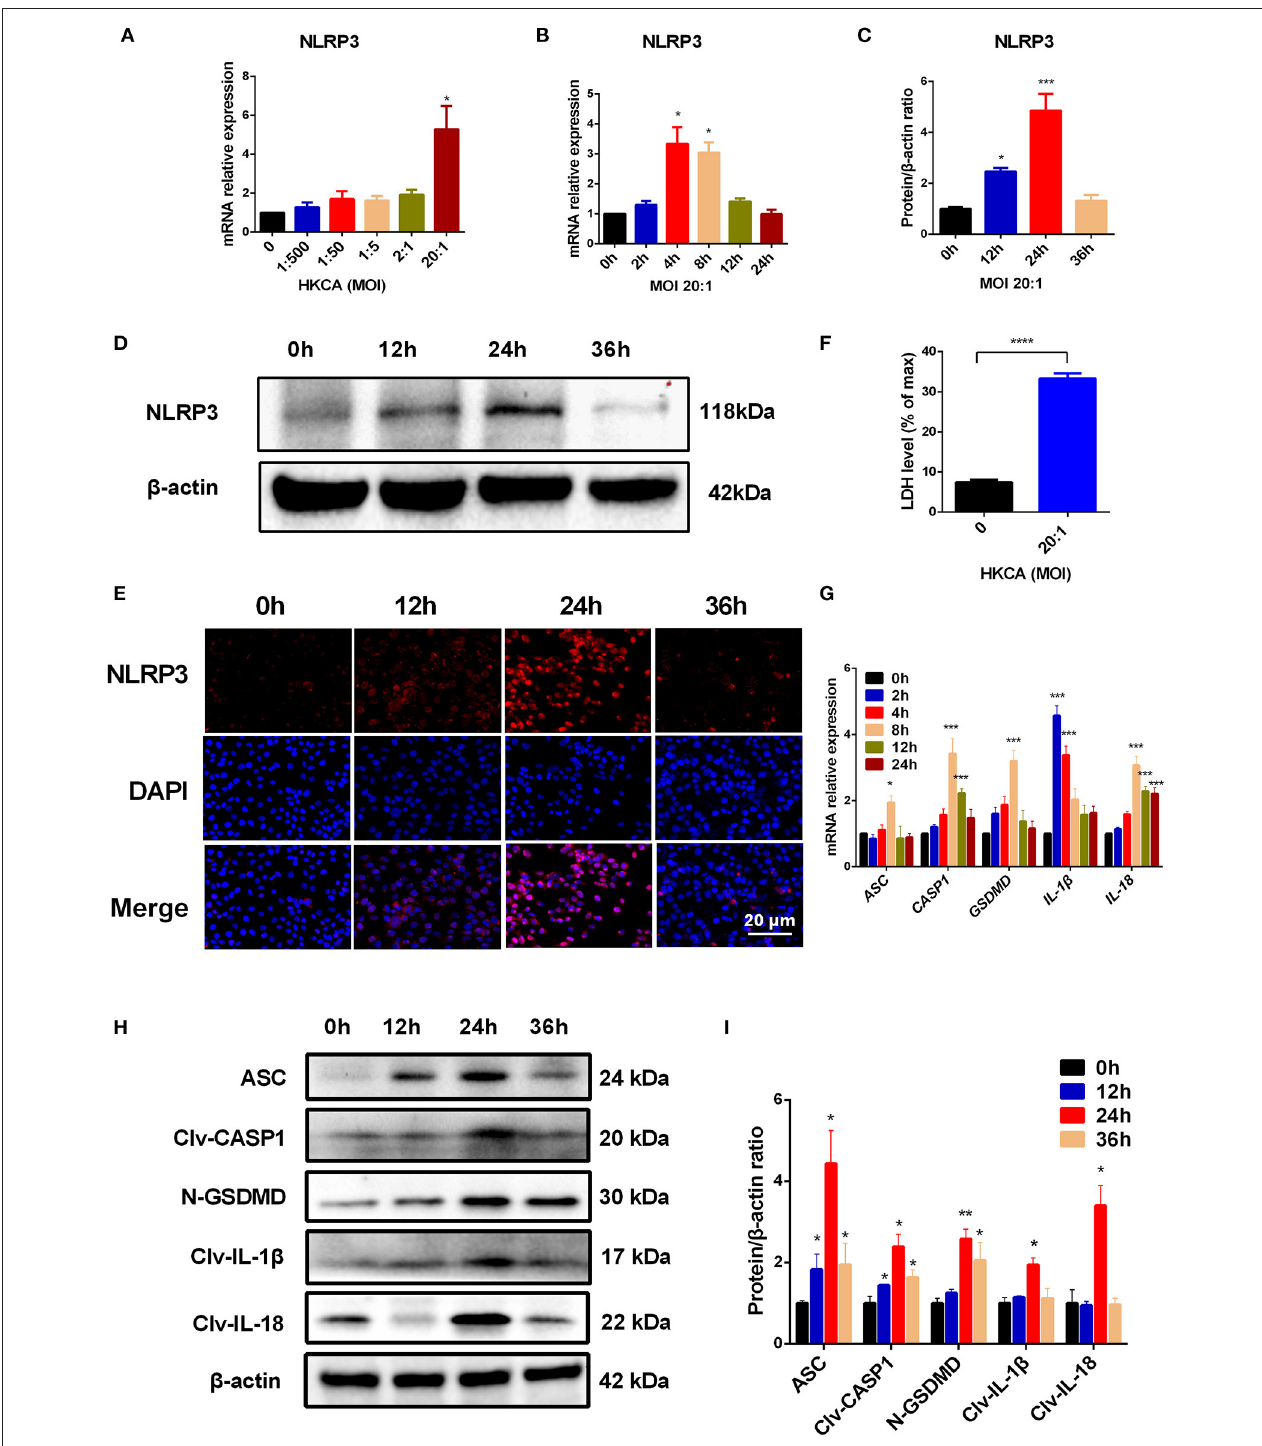
FIGURE 5 | Heat-killed C. albicans (HKCA) activates NLRP3 inflammasome and induces pyroptosis in human corneal epithelial cells (HCECs). (A) The mRNA expression of NLRP3 in HCECs challenged with HKCA at an MOI of 1:500, 1:50, 1:5, 2:1, or 20:1 respectively for 4 hours was evaluated by RT-qPCR ( n = 5). (B–D) The mRNA and protein expression of NLRP3 in HCECs exposed to HKCA (MOI = 20) for 0 (control), 2, 4, 8, 12, or 24h ( n = 3). (E) NLRP3 fluorescence intensity was evaluated using immunofluorescent staining for different times (12–36h). ( n = 3; Scale bar = 20 µ m; magnification 400 × ). (F) Lactate dehydrogenase (LDH) of HCECs treated with HKCA (MOI = 20) for 24h ( n = 6). (G) The mRNA levels of ASC, CASP1, IL-1 β , IL-18 and GSDMD in HCECs exposed to HKCA (MOI = 20) for different times ( n = 3). (H,I) The protein expression of pyroptosis-related proteins (ASC, cleaved CASP1, N-GSDMD, cleaved IL-1 β and cleaved IL-18) was examined by western blot ( n = 3). CASP1: caspase-1; Clv-CASP1: cleaved CASP1; Clv-IL-1 β : cleaved IL-1 β ; Clv-IL-18: cleaved IL-18; N-GSDMD: cleaved p30 form of GSDMD. All values are presented as mean ± SEM. * p < 0.05; ** p < 0.01; *** p < 0.001; **** p < 0.0001 vs. control group.